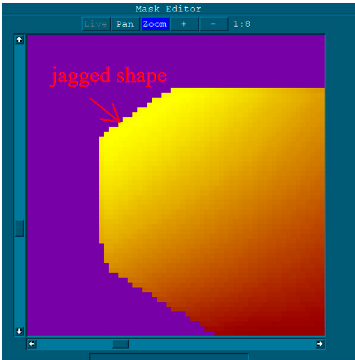
Figure 11. 24 inch interferometer measurement results (resolution 0.00066 m).